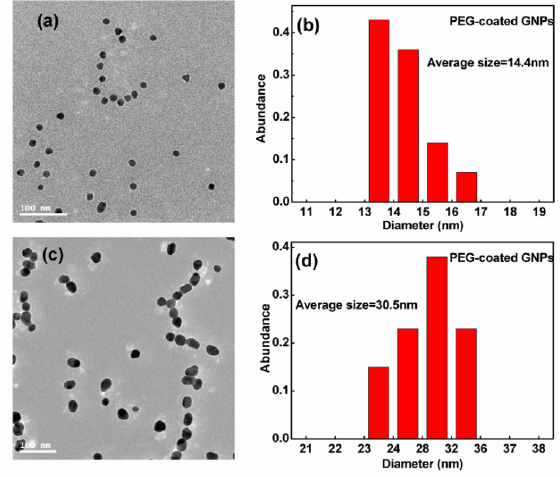
Figure 2. ( a , c ) Transmission electron microscopy (TEM) images of 14.4 and 30.5 nm GNPs; Figure 2. ( a ) and ( c ) Transmission electron microscopy (TEM) images of 14.4 and 30.5 nm GNPs; ( b , d ) corresponding distribution of 14.4 and 30.5 nm ( b ) and ( d ) corresponding distribution of 14.4 and 30.5 nm GNPs.